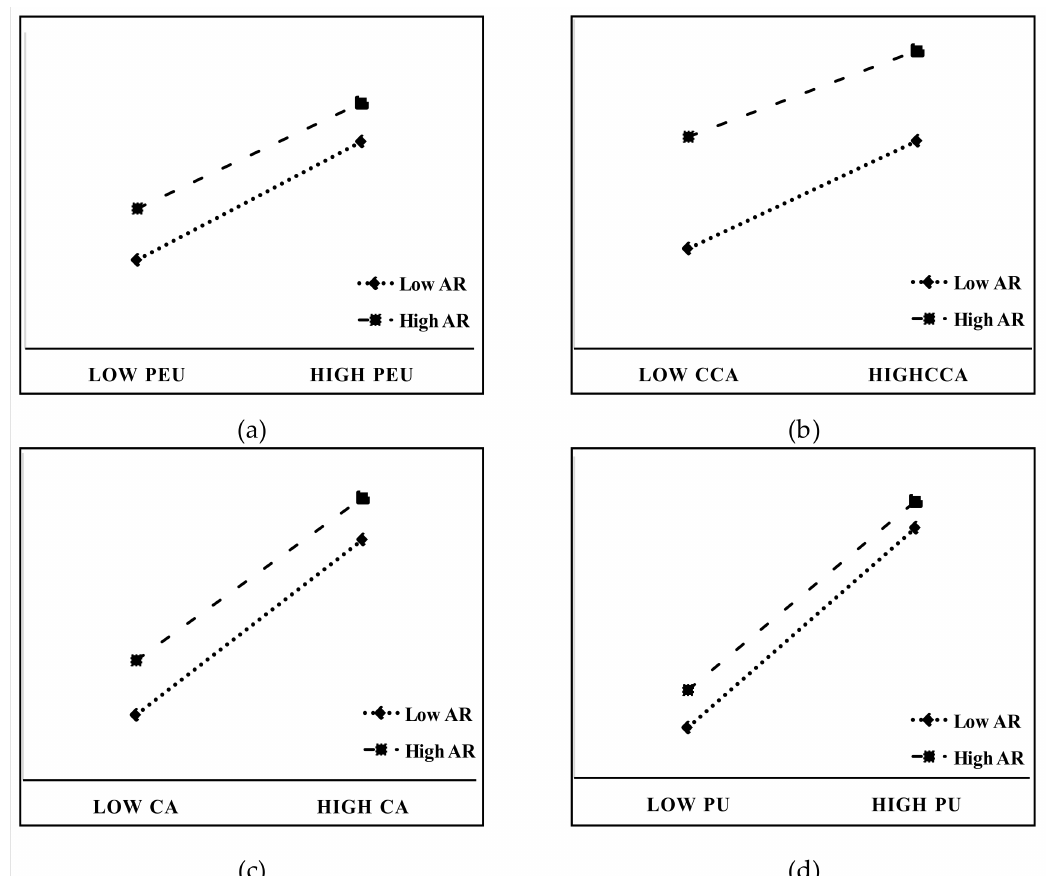
Figure 3. Mediated moderator effect. ( a ) Regulating Action Diagram (PEU-LW); ( b ) Regulating Action Diagram (CCA-CA); ( c ) Regulating Action Diagram (CA-LW); ( d ) Regulating Action Diagram (PU-LW).